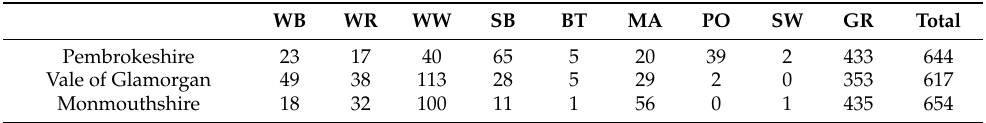
Table 2. Number and crop type of the parcels used for validation of the national crop maps for Wales (i.e., proposed knowledge-based, CEH, and OneSoil maps). WB WR WW SB BT MA PO SW GR Total Pembrokeshire 23 17 40 65 5 20 39 2 433 644 Vale of Glamorgan 49 38 113 28 5 29 2 0 353 617 Monmouthshire 18 32 100 11 1 56 0 1 435